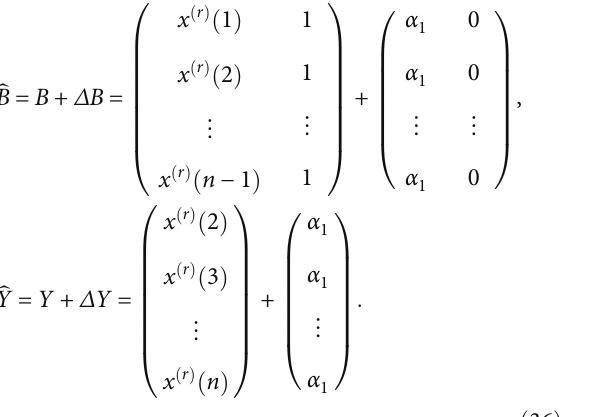
ffiffiffiffiffiffiffiffiffiffi p ffiffiffiffiffiffiffiffiffiffi x k k n − 1